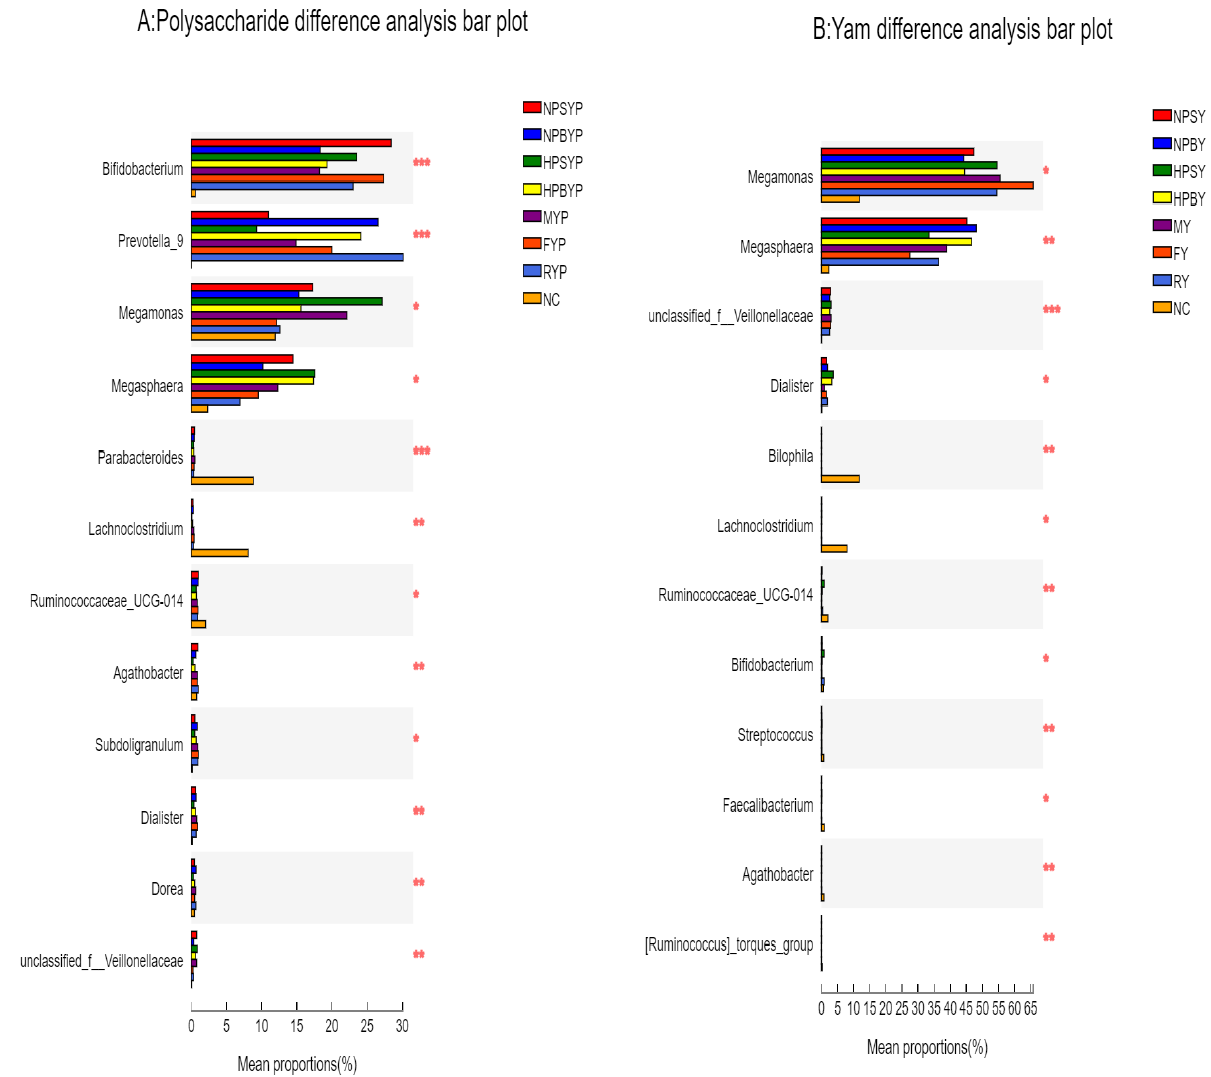
Figure 2. Bar chart of multi-species difference test. Note: A = Polysaccharide difference analysis bar plot, B = Yam difference analysis bar plot. The Y axis represents the species name at a taxonomic level, the X axis represents the average relative abundance in different groups of species, and the columns with different colors represent different groups. The rightmost side shows the p value, * 0.01 < p ≤ 0.05, ** 0.001 < p ≤ 0.01, *** p ≤ 0.001. NC = blank, NPSY = Normal-pressure steamed yam, NPBY = Normal-pressure boiled yam, HPSY = High-pressure steamed yam, HPBY = High-pressure boiled yam, MY = Microwaved yam, FY = Stir-fried yam. RY = Raw yam. NPSYP = Normal- pressure steamed yam polysaccharide, NPBYP = Normal-pressure boiled yam polysaccharide, HP- SYP = High-pressure steamed yam polysaccharide, HPBYP = High-pressure boiled yam polysac- charide, MYP = Microwaved yam polysaccharide, FYP = Stir-fried yam polysaccharide, RYP = Raw yam